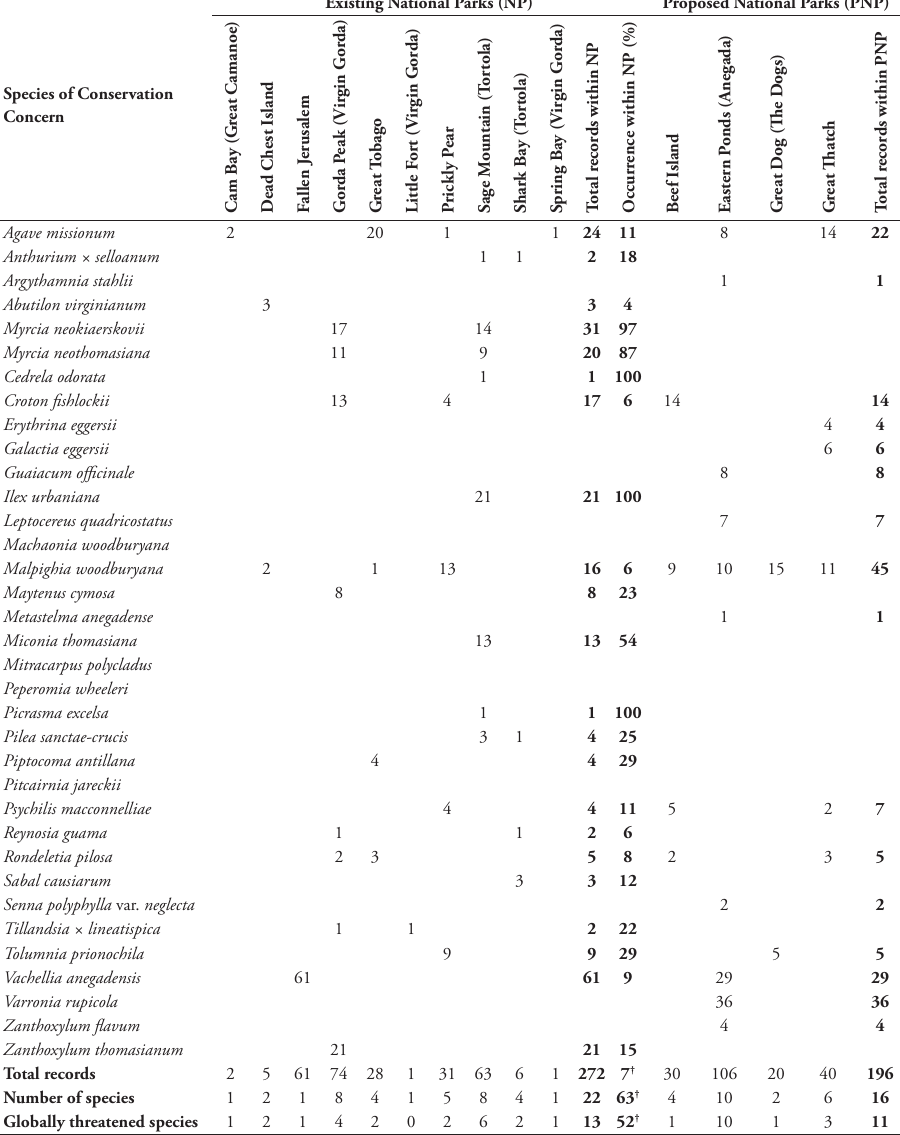
Table 3. National Parks and occurrence of Species of Conservation Concern in the British Virgin Islands. National Parks without any records for the species are not listed. Location of National Park in () if not entire island. † Indicates percentage instead of number of